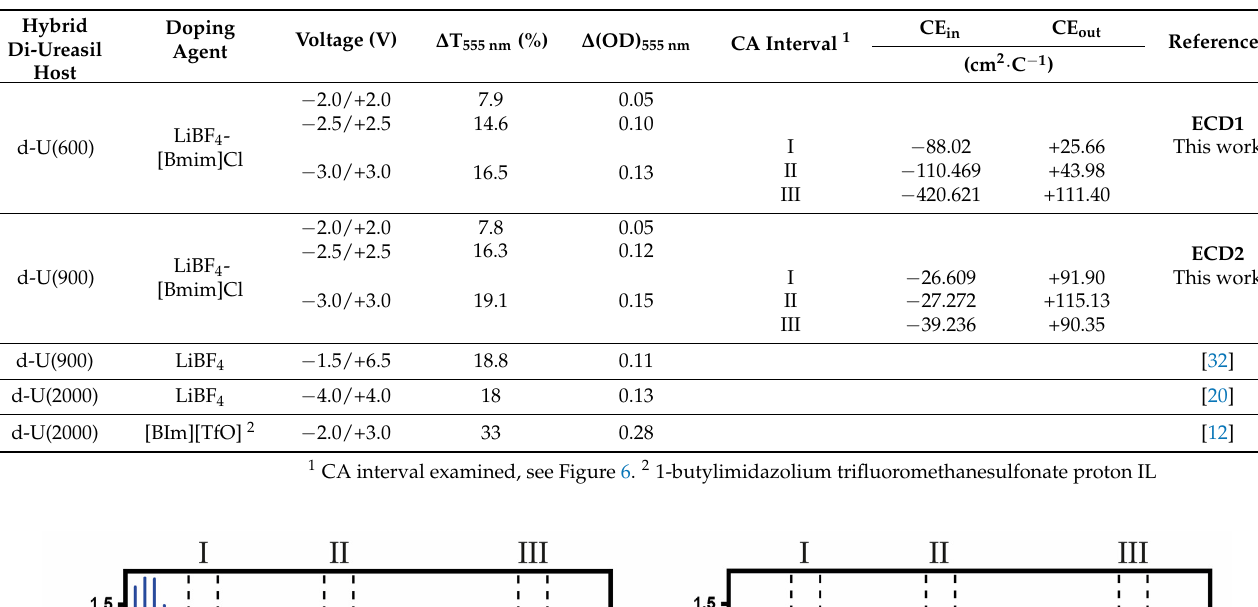
Table 1. Parameters for ECDs characterization.